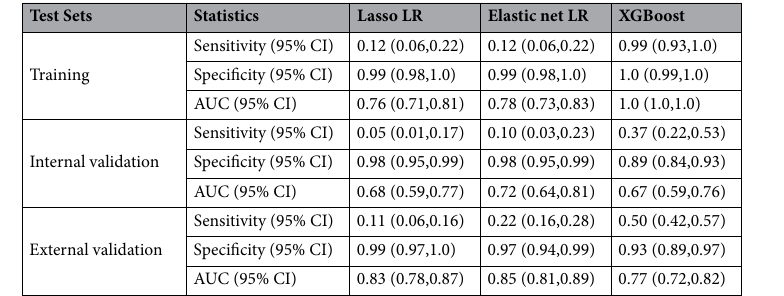
Table 3. Model performance in the training, internal and external validation sets for in-hospital mortality. The cutoff threshold to determine sensitivity and specificity was 0.5